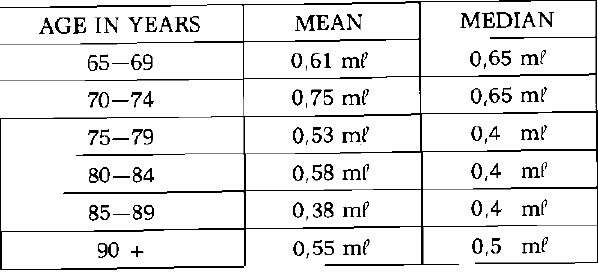
Table 3: Correlation between age and mean and me- dian static immittance results in millilitres